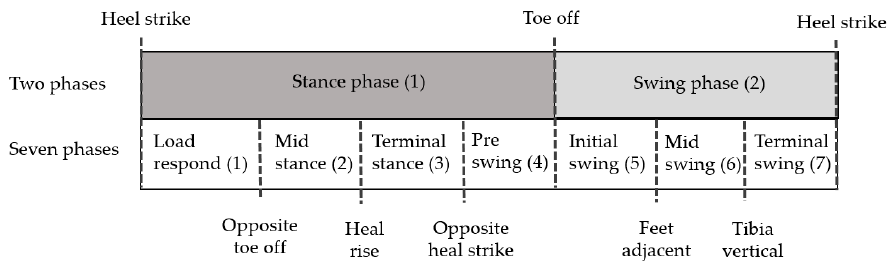
Figure 1. Two and seven gait phases.